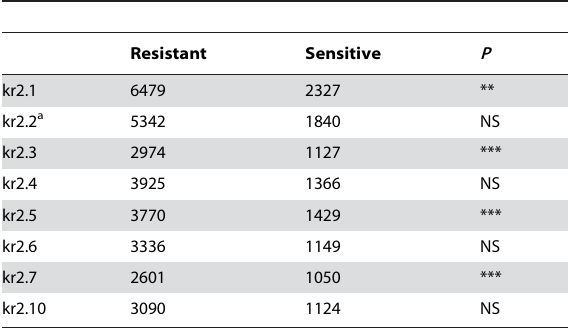
Table 2. Overall segregation of kanamycin resistance in self- fertilised progeny of